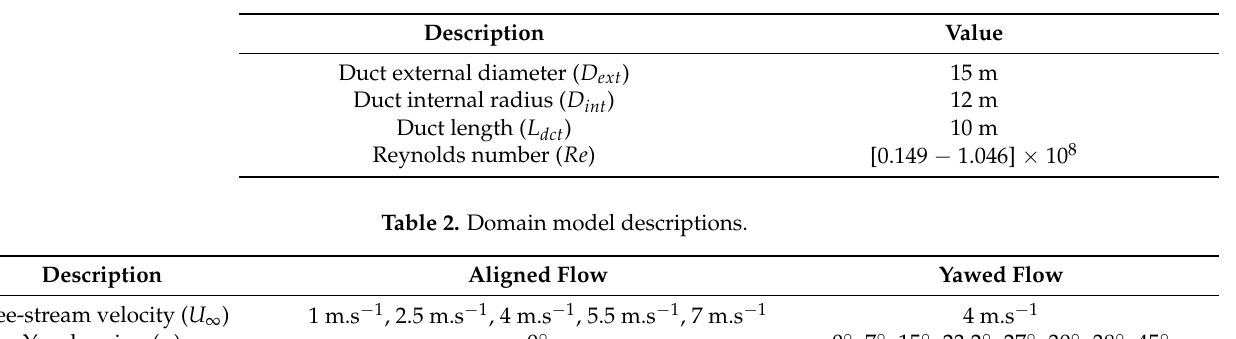
Table 1. Duct model descriptions.